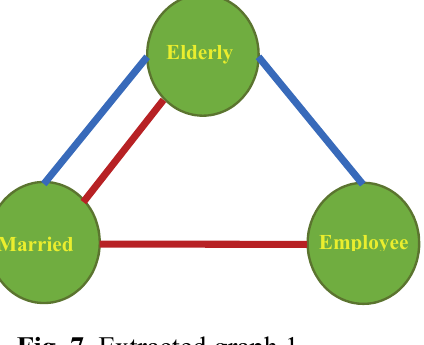
Fig. 7. Extracted graph